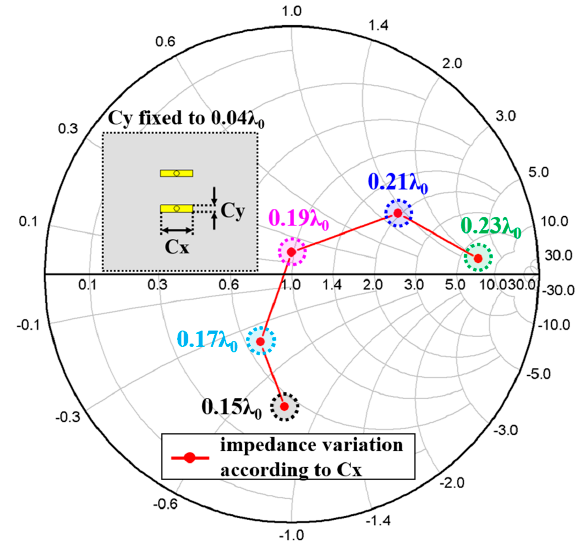
Figure 3. Proposed antenna structure with impedance variation according to Cx value.